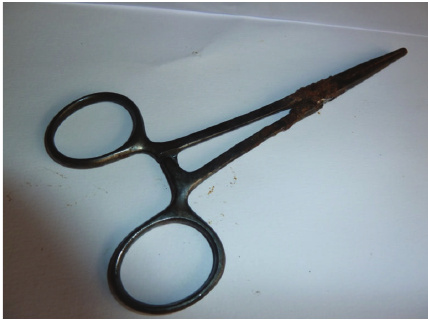
Figure 2: Retrieved Kocher’s surgical